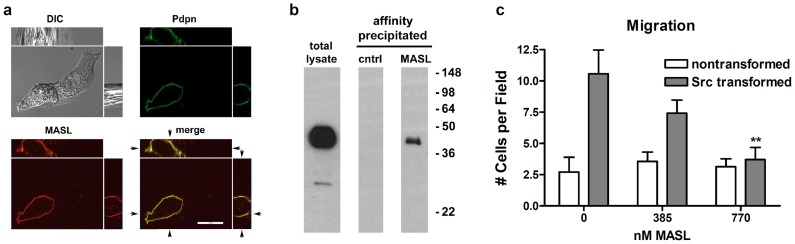
MASL associates with PDPN and inhibits migration of Src transformed cells.(a) Src transformed cells were exposed to MASL conjugated to HiLyte Fluor TR (red), and PDPN was detected by immunofluorescence microscopy (green). Colocalization of lectin and PDPN (yellow) is apparent in merged images, including orthogonal views of the z-axis which is 14 microns thick (bar = 20 microns). (b) Protein from Src transformed cells (750 μg) was precipitated with agarose beads linked to MASL, or control beads, and examined for PDPN by Western blotting. Cell lysate (15 μg/lane) were also examined as indicated. (c) Wound healing migration assays were performed on confluent monolayers of cells treated with concentrations of MASL as indicated. Data are shown as the number of cells that migrated into a 300x300 micron area along the center of the wound in 24 hours (mean + SEM, n = 7). Double asterisks indicate p<0.01 compared to nontransformed cells.